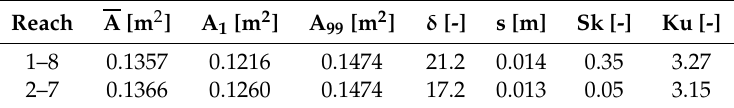
Table 2. Characteristic values derived from the distribution curves of the cross-sectional areas, standard deviation, skewness, and kurtosis for reaches 1–8 and 2–7 (in model scale).